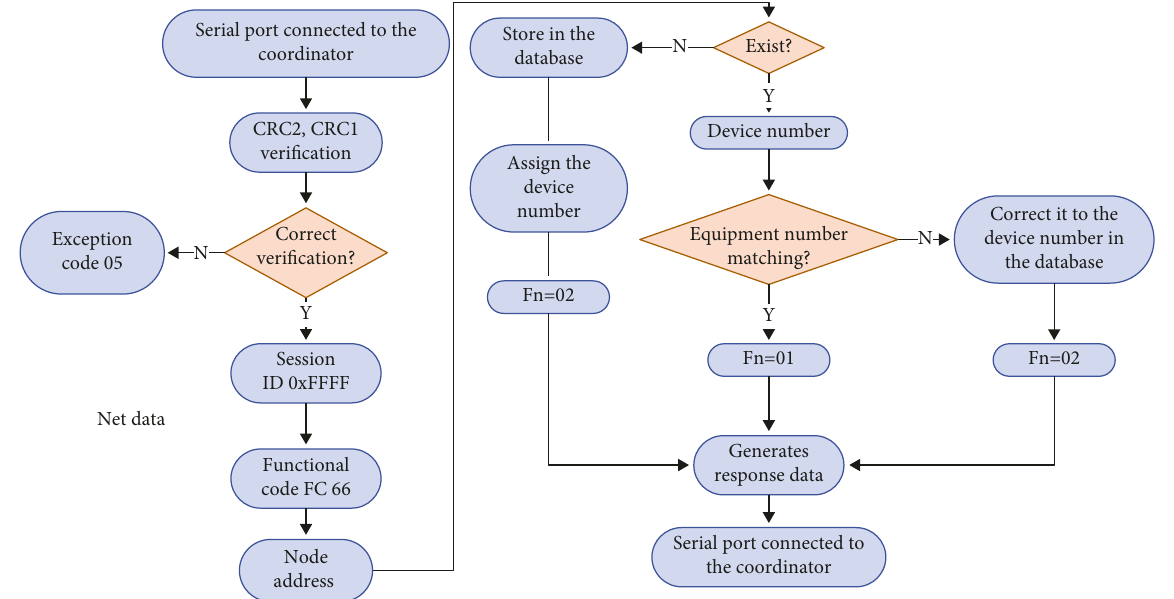
Figure 8: The flowchart of terminal processing of network access data.